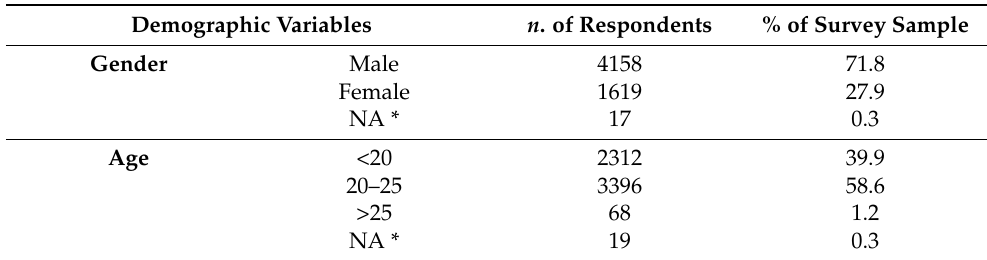
Table 2. Demographics of respondents to the Chinese College Students Animal Welfare Attitude Scale questionnaires